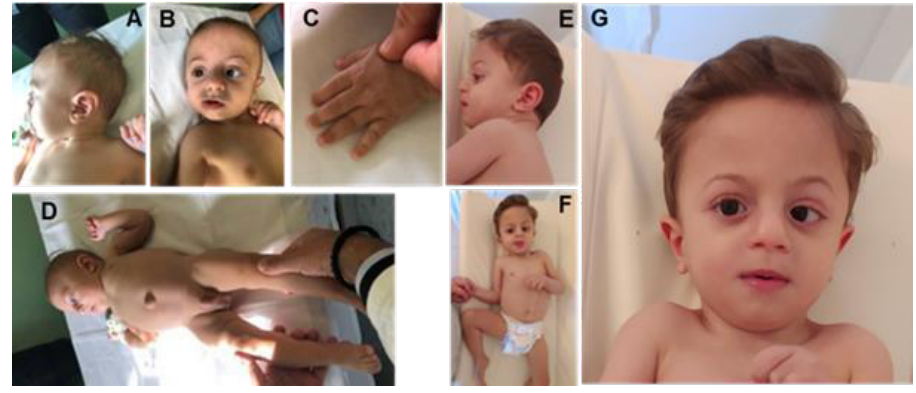
Figure 1. Patient at 6 months ( A – D ), 20 months ( E – G ). 2.3. Clinical Exome Sequencing (CES) as Previously Reported [11].